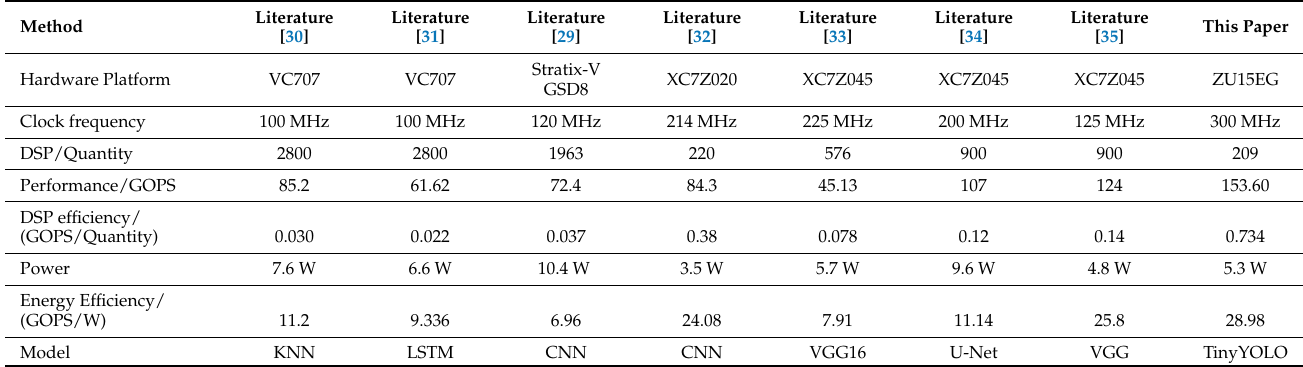
Table 7. Comparison of different literature methods.